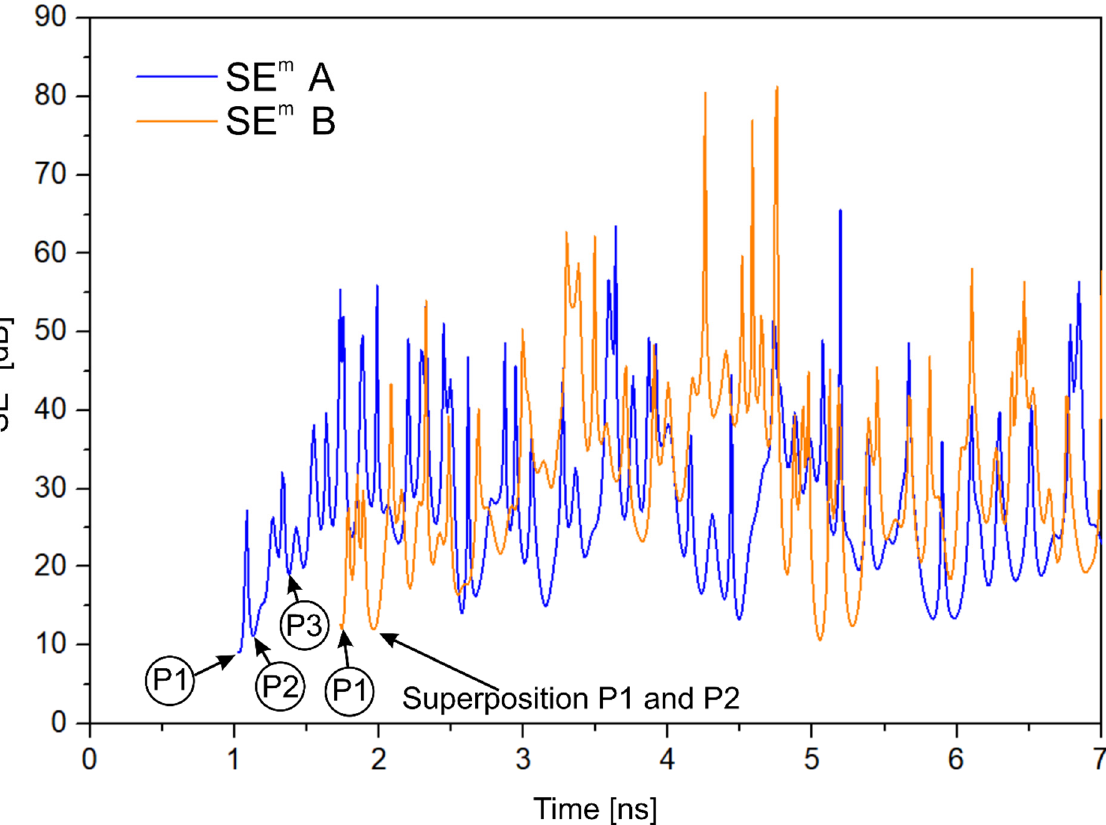
Figure 11. Time-dependence of the shielding effectiveness SE m of the magnetic field at points A (0, 0, 0) and B (0, 0, − 211.5) over 0–7 ns—the local SE e versus time. The SE m labeled P1, P2, and P3 (in circles) correspond to the passages of the primary waves P1, P2, and P3 through points A and B. The SE m labeled “Superposition P1 and P2” corresponds to the constructive interference of the primary waves P1 and P2 moving in opposite directions to each other.